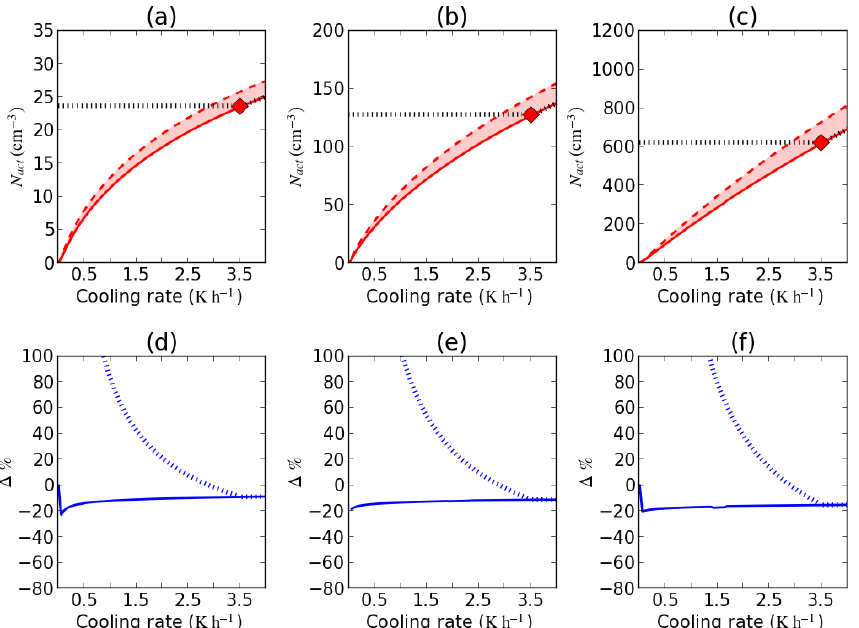
Figure 2. (a) Total activated aerosols, N act , against the cooling rate for marine environment accumulation-mode aerosols. Solid line – T_ship_mar_acc; dashed line – T_SMOD_mar_acc; black dashed line – T_ship_mar_acc_wmin. (d) Percentage differences, (cid:49) %, between the following: dashed line – T_ship_mar_acc against T_ship_mar_acc_wmin; solid line – T_ship_mar_acc against T_SMOD_mar_acc. Red diamond – w min = 0 . 1ms − 1 ; (b, e) clean continental; (c, f) urban. Table 4. The input parameters and model setup for IOP1 in